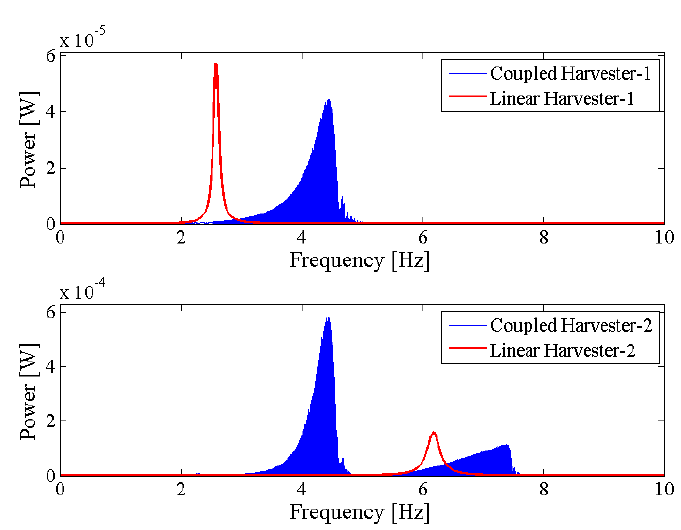
Figure 7. Output voltage of the NPEHS-1.